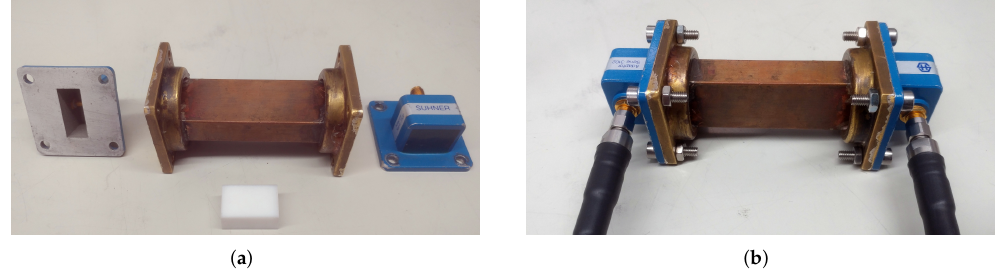
Figure 3. Waveguide as sample holder, MUT, and connection with the network analyser. ( a ) WR90 waveguide with coaxial adaptors and PTFE material sample; ( b ) assembled waveguide connected to the network analyser.